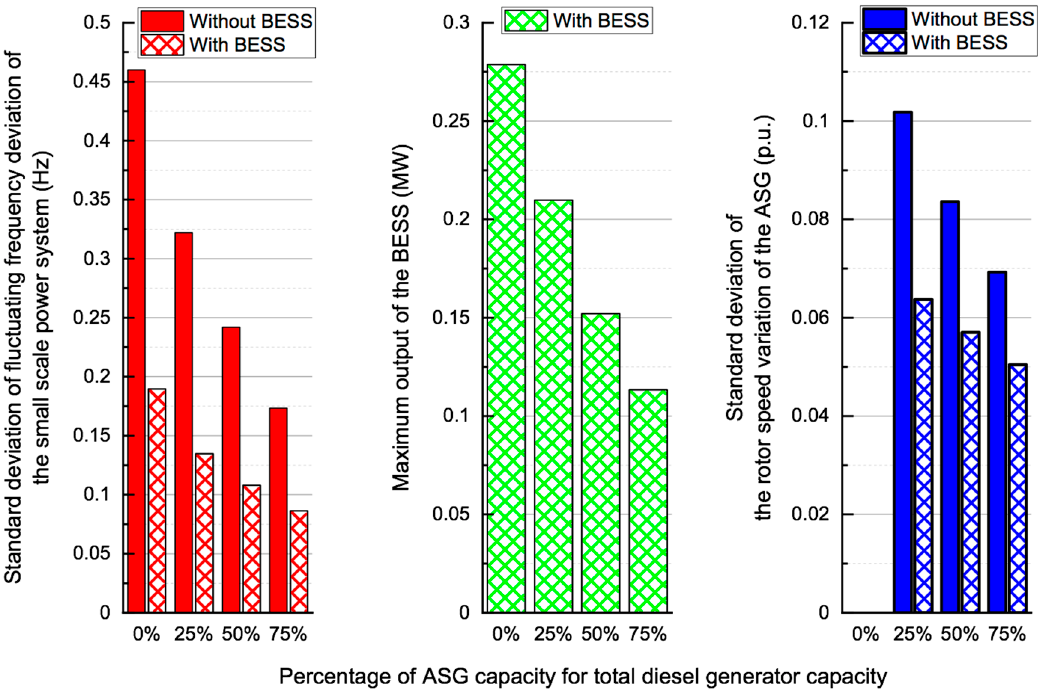
Figure 15. Standard deviation of the power system frequency, maximum power of the BESS and rotor speed variation of the ASG.